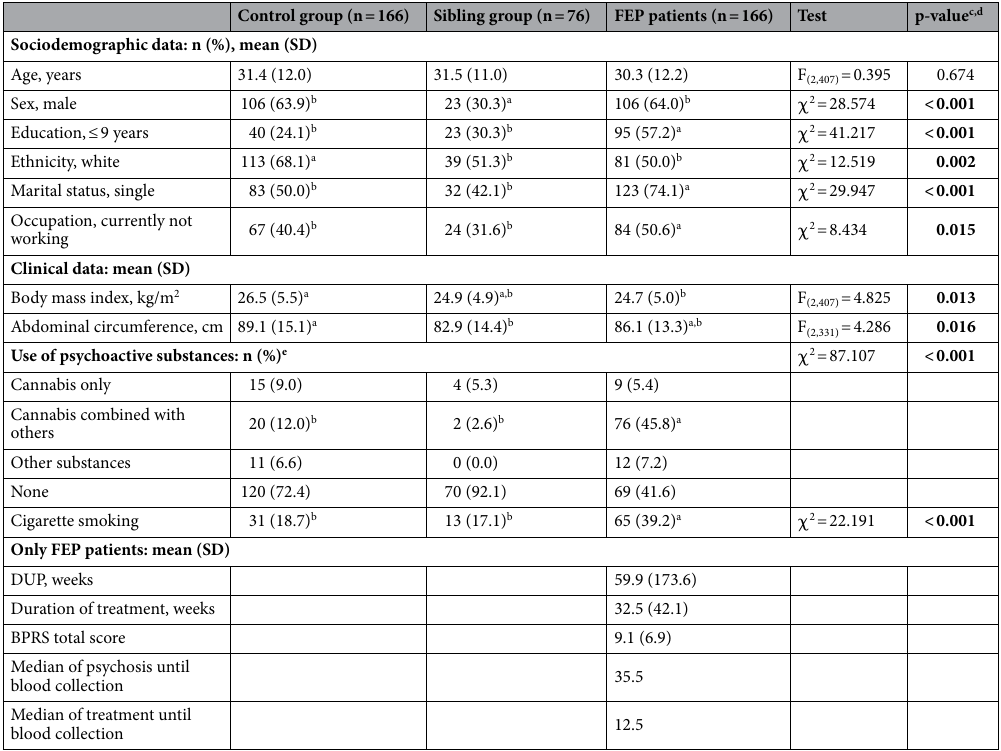
Table 1. Sociodemographic and clinical variables from FEP patients, non-psychotic siblings and matched community-based controls. FEP first-episode psychosis, SD standard deviation, DUP Duration untreated psychosis, BPRS brief psychiatric rating score. Bold: p ≤ 0.05. a,b Means followed by the same letter did not differ statistically from each group in the table. Different subscript letters represent the significant differences between groups. c One-way ANOVA with Bonferroni correction. d Chi-square test. e Use of psychoactive substances (current or lifetime): Cannabis; alcohol; cocaine/crack; inhalants;